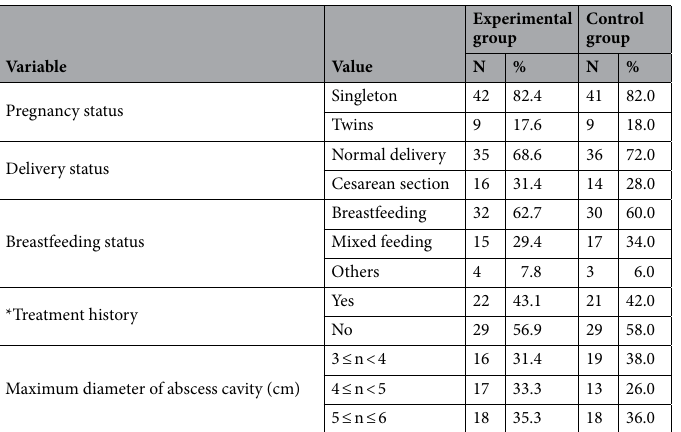
Table 1. Basic information of the two groups. *Treatment history included the use of antibiotics before and during the study period. Of the 22 cases in the experimental group, 18 were treated with cephalosporins and four with other antibiotics. Of the 21 cases in the control group, 14 were treated with cephalosporins and seven with other antibiotics.